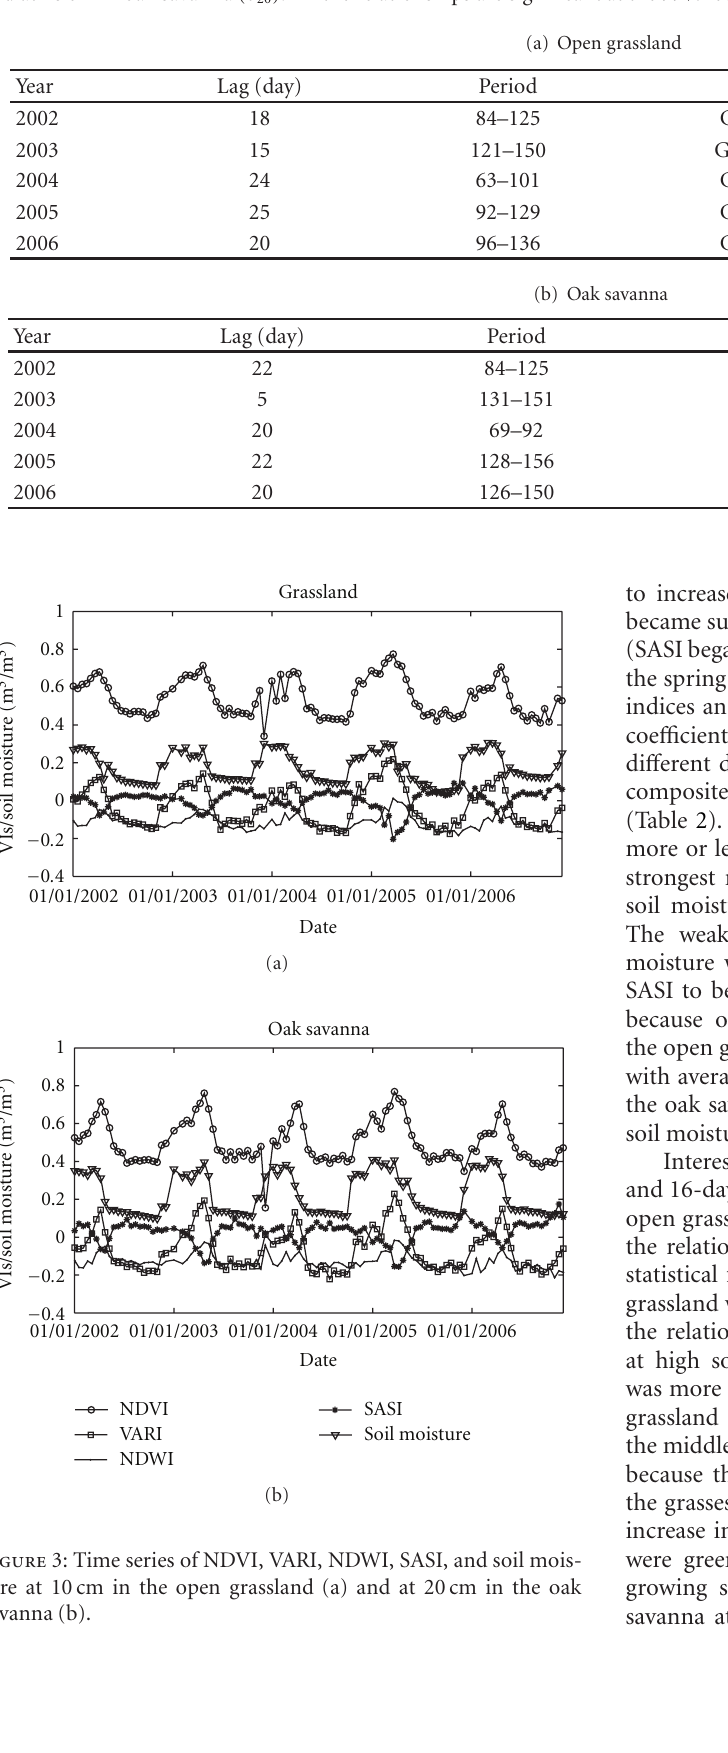
Table 1: Regression models and statistics of relationships between GPP and lagged volumetric soil moisture at 10cm in open grassland ( θ 10 ) and at 20cm in oak savanna ( θ 20 ). All the relationships are significant at the 99% level.